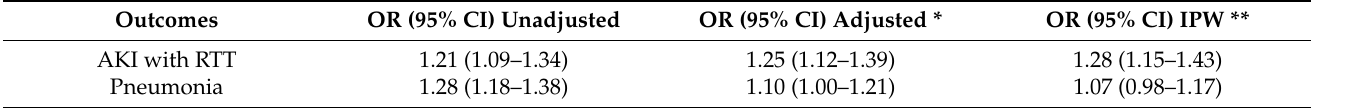
Table 3. Risks of outcome with NSAID